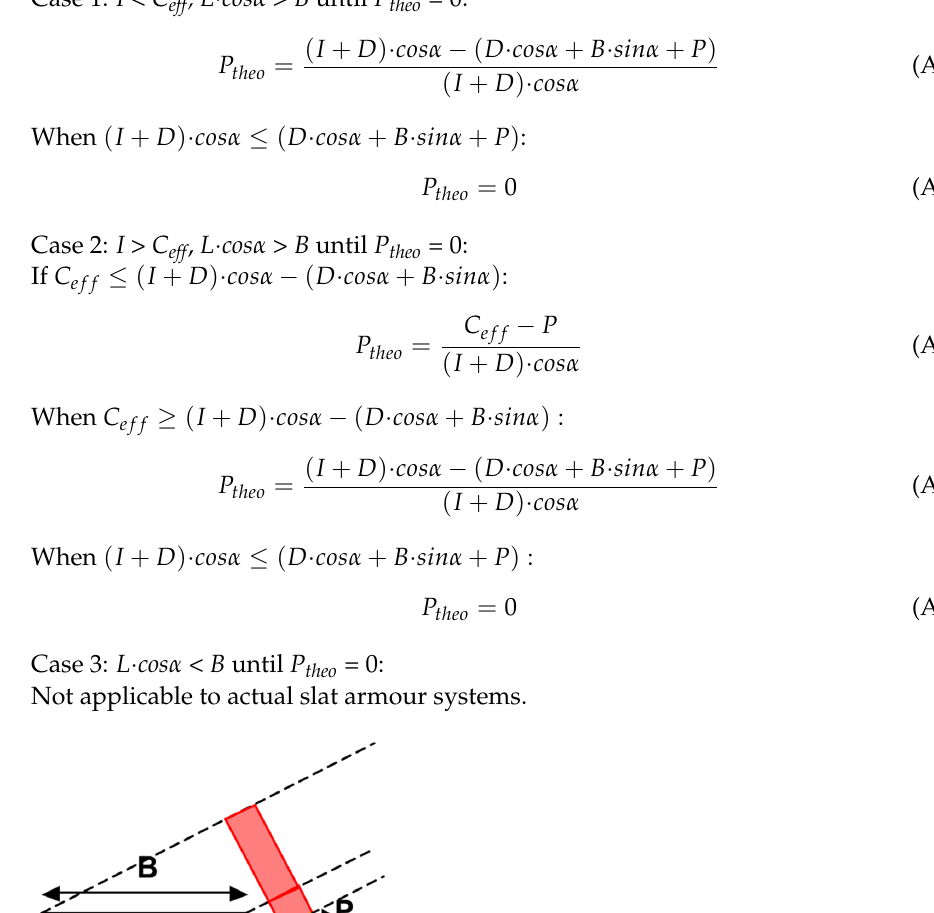
Figure A1. Geometric properties of the projectile affecting the cage armour efficiency.